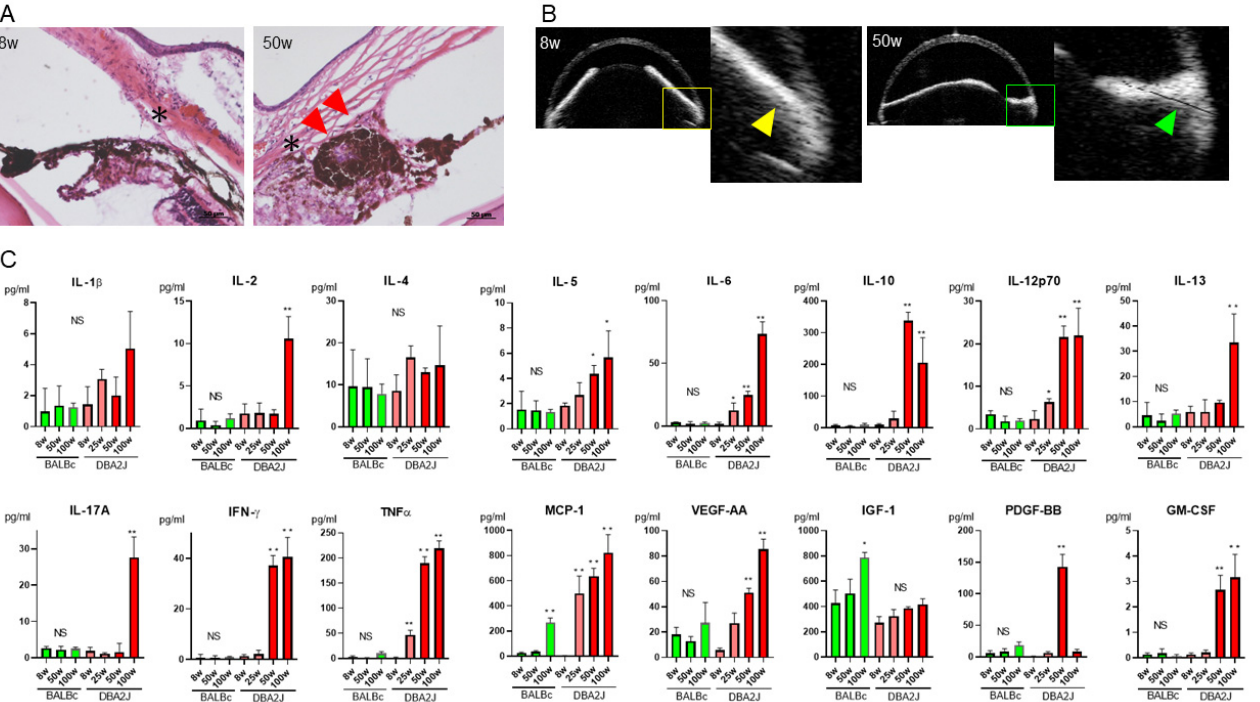
Figure 2. Age-dependent increase of cytokine levels in AqH in DBA2J mice. ( A ) The angle structure and iris tissue were normal in DBA2J at 8 weeks (* Schlemm’s canal); however, peripheral synechiae (PAS), iris nodules and iris atrophy developed at 50 weeks (red arrows). Scale bars: 50 µ m. ( B ) In vivo anterior segment optical coherence tomography showed the absence of PAS at 8 weeks (white arrowheads), whereas PAS developed at the age of 50 weeks (green arrowhead). ( C ) The AqH levels of IL-2, IL-5, IL-6, IL-10, IL-12p70, IL-13, IL-17A, IFN- γ , TNF- α , MCP-1, PDGF-BB and GM-CSF were significantly elevated at 50 and 100 weeks in DBA2J, compared to 8 weeks in DBA2J. * p < 0.05, ** p < 0.001.